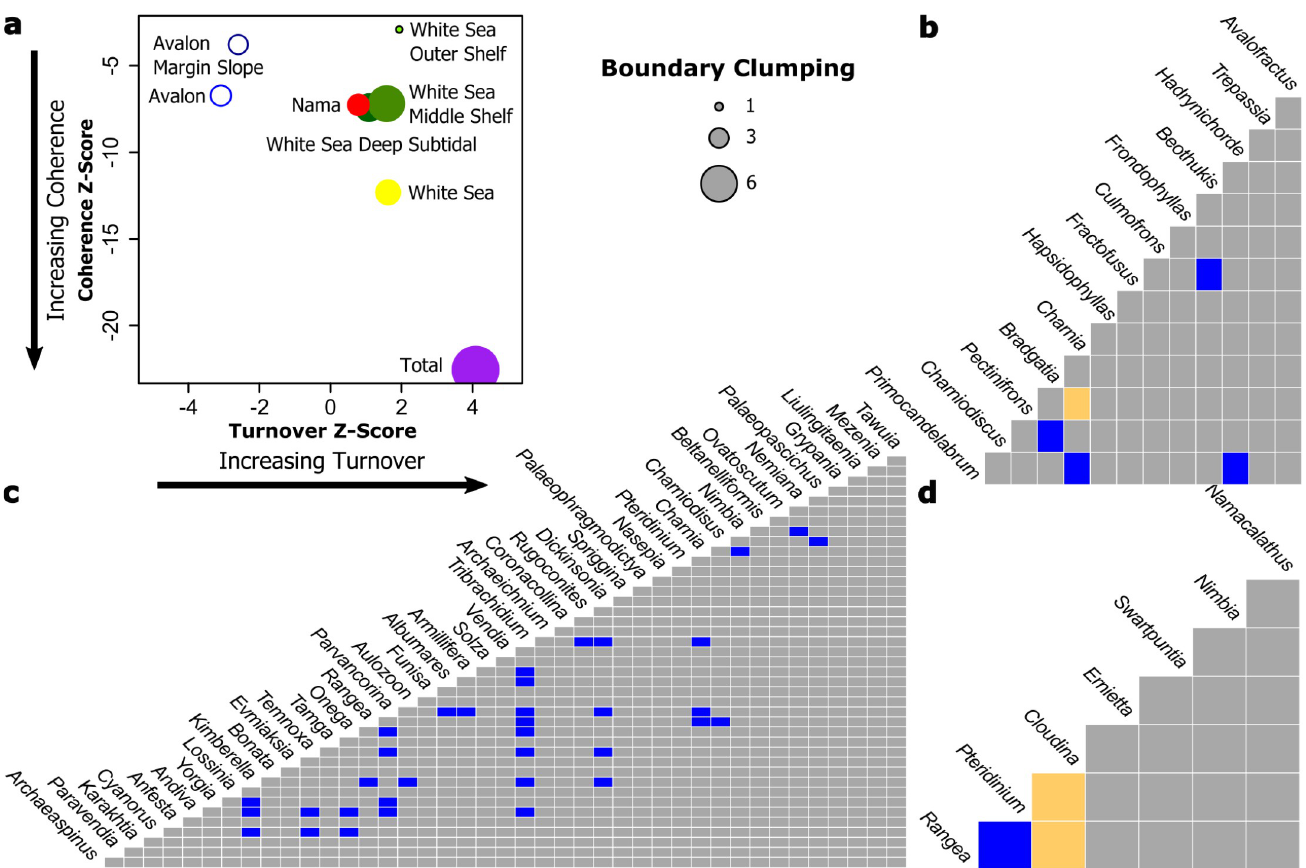
Fig 3. Metacommunity analyses and co-occurrence matrices for each assemblage. (a) Metacommunity plot shows a summary of the metacommunity analyses. The z-score is a standardised way to indicate how much the observed means differ from the average across all communities in terms of standard deviations. Nested species loss is shown by an open circle; Clementsian by a closed circle; Gleasonian by a black ringed circle. The size of the circle represents the value of the boundary clumping score. The Avalonian outer shelf had a random structure and so is not shown. Co-occurrence matrices for ( b) the Avalon metacommunity, ( c) the White Sea metacommunity, and ( d) the Nama metacommunities. Positive associations are blue; negative associations are yellow.